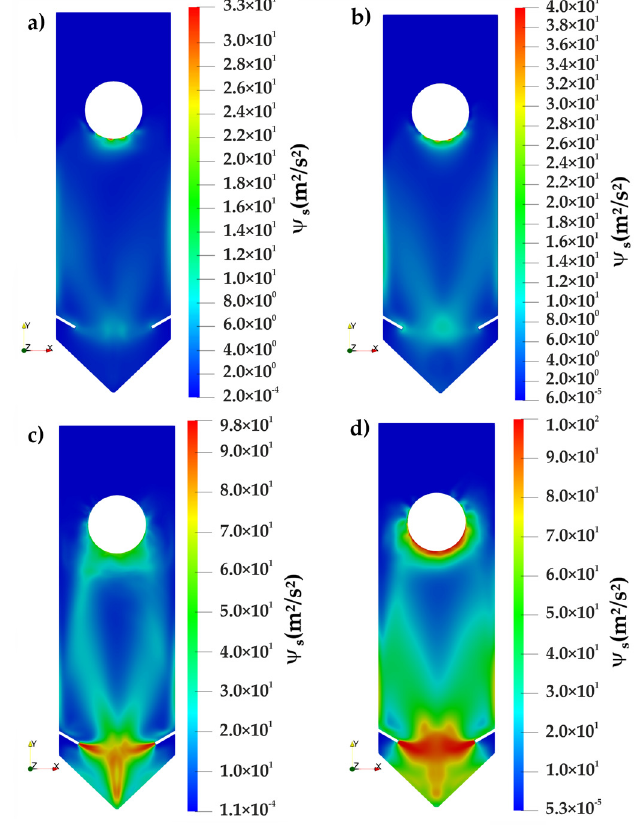
Figure 17. Time-averaged granular temperature distribution as a function of the solid holdup and the nozzle inlet pressure: ( a ) 400 g and 0.5 bar; ( b ) 400 g and 1 bar; ( c ) 700 g and 0.5 bar; ( d ) 700 g and 1 bar.